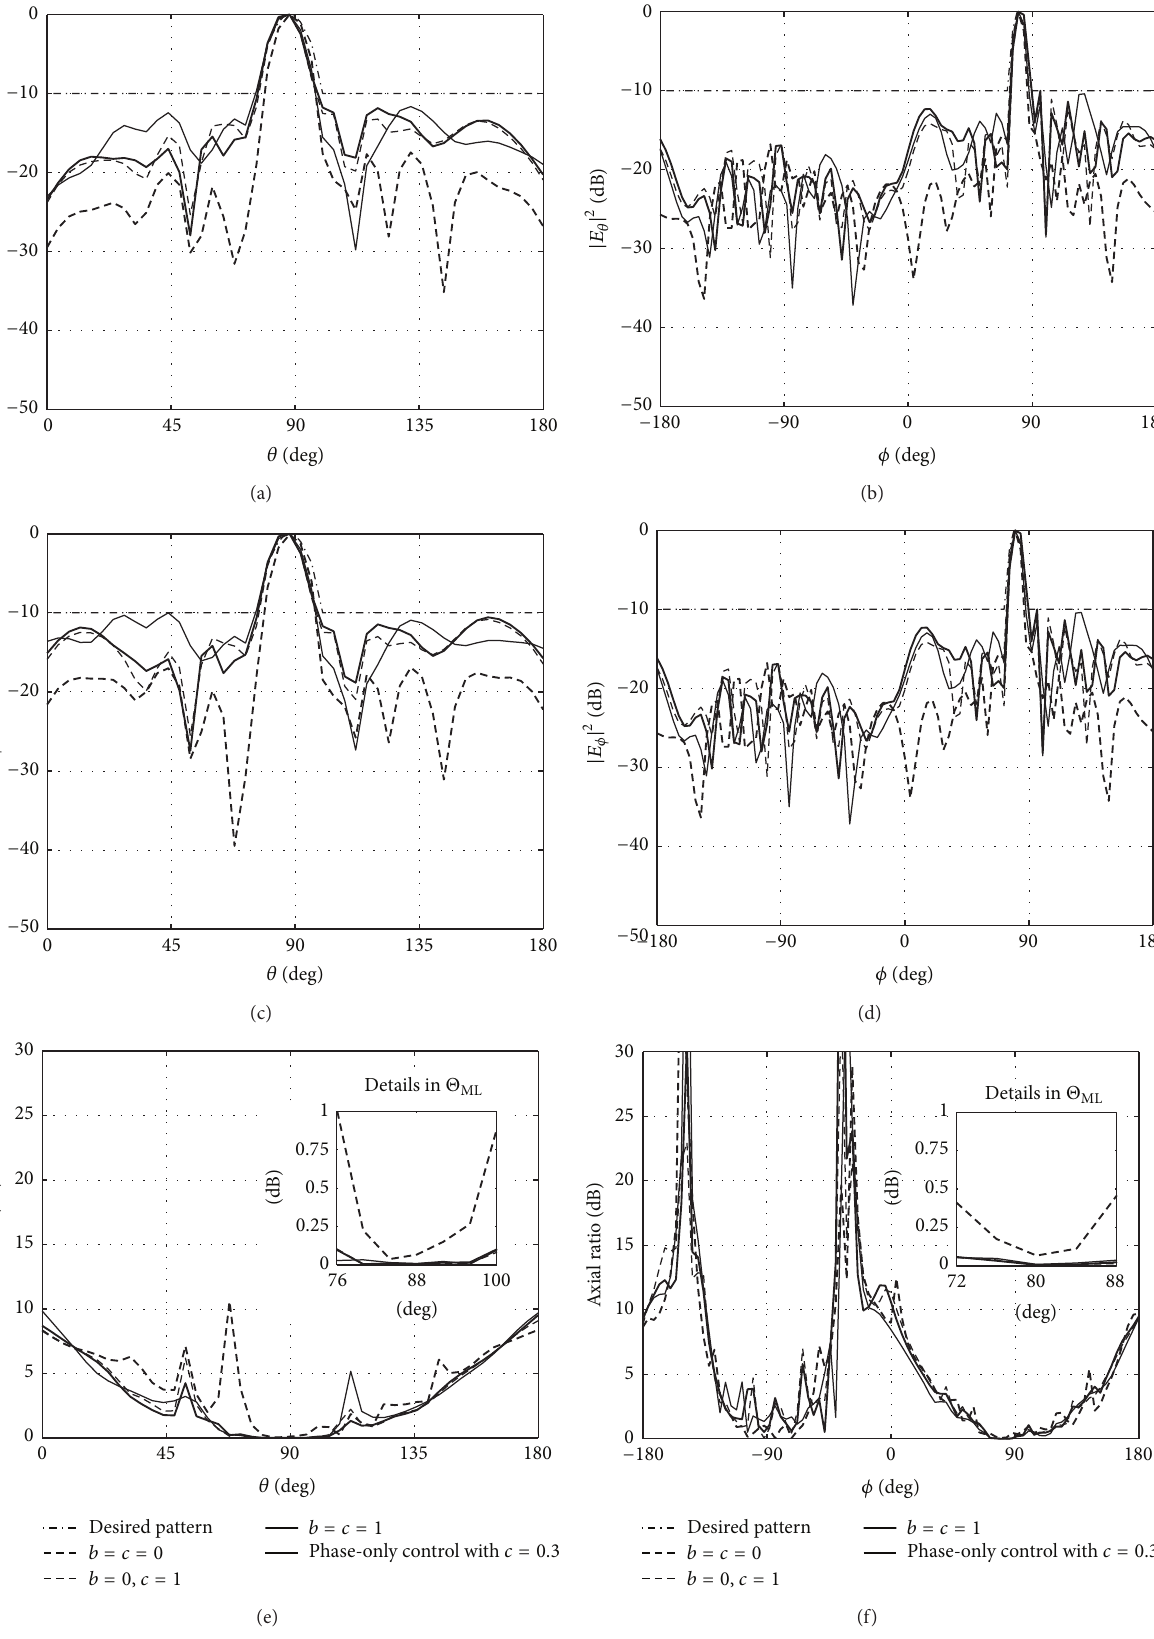
= 80 ∘ , and (f) axial ratio for 𝜃 = 𝜃 0